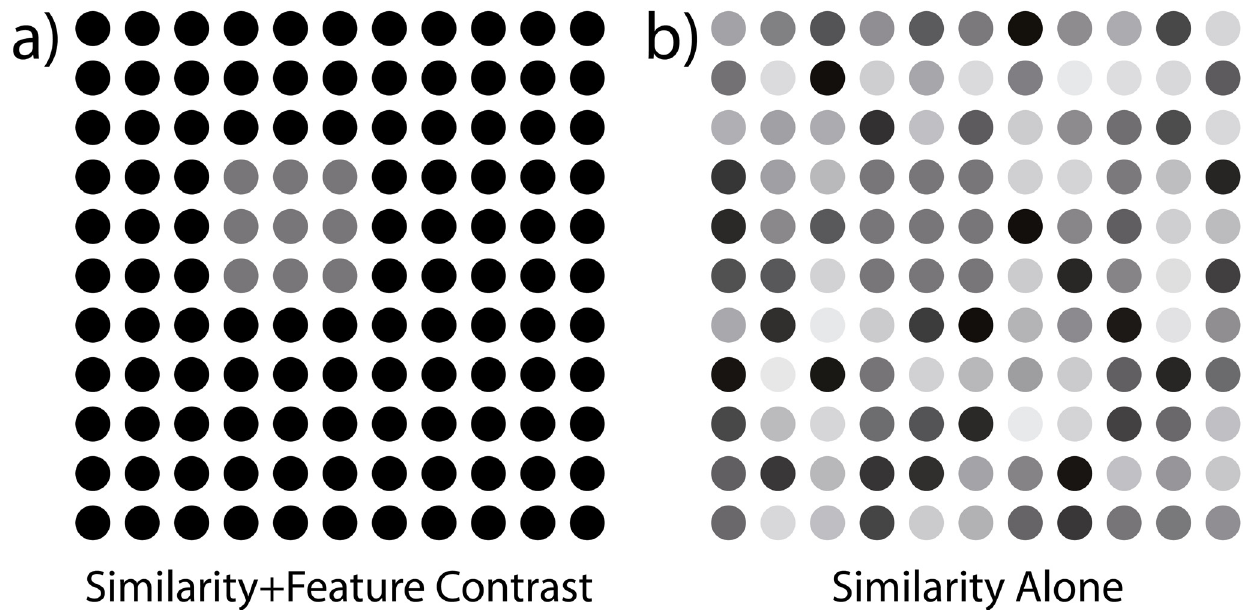
Fig 1. Comparison of grouping cues. (a) illustrates the combination of element similarity and luminance contrast to make the foreground figure visible, (b) removes the feature contrast but adds variability among background elements while keeping the mean luminance of foreground and background equal. Luminance variability is sampled uniformly from the entire interval of available luminance